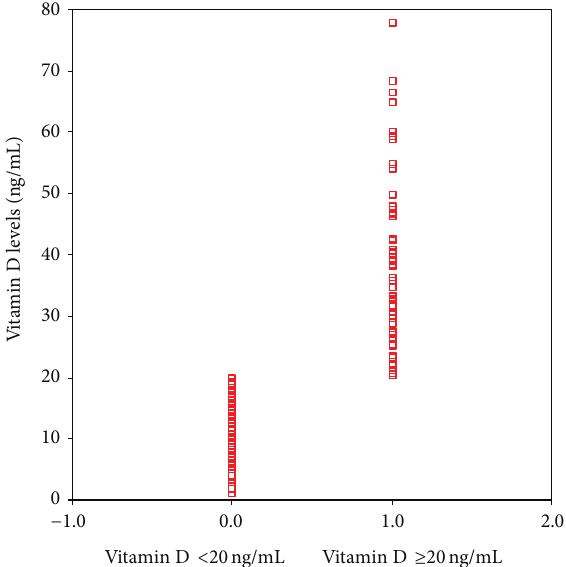
Figure 2: Vitamin D levels of vitamin D sufficient ( ≥ 20ng/mL) and insufficient ( < 20ng/mL) groups (𝑃 = 0.001) .